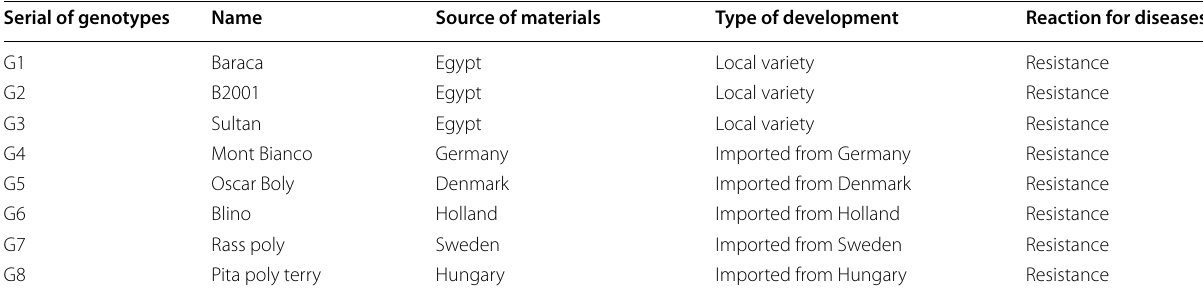
Table 1 The Origin of 8 sugar beet entries Serial of